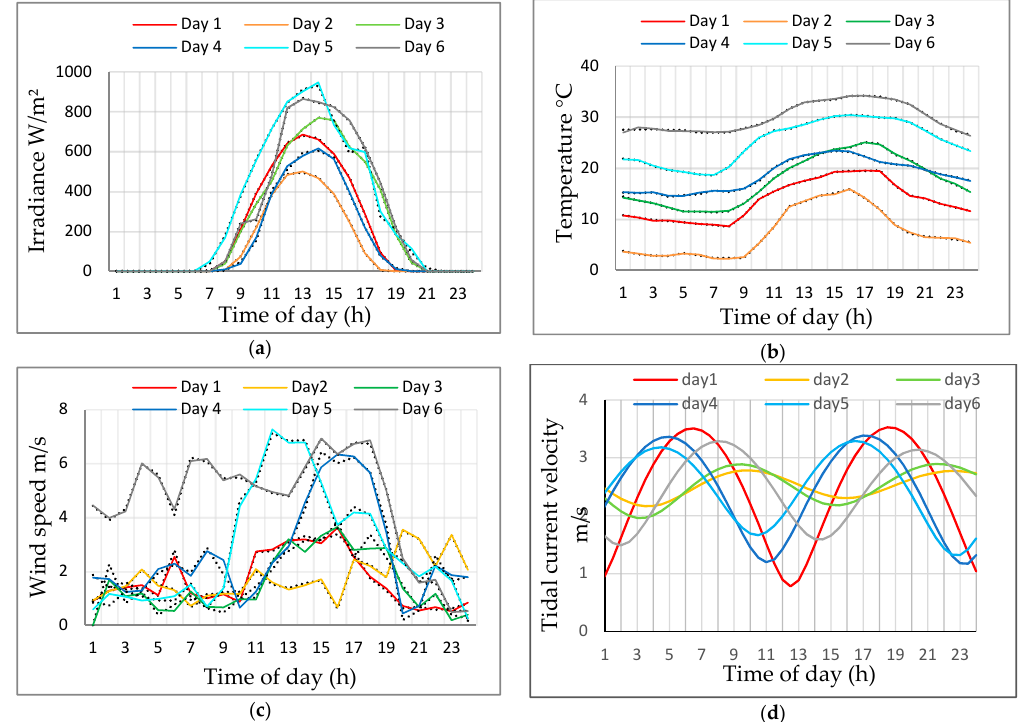
Figure 4. Data used as input to renewable energy systems (RES) models ( a ) Solar irradiance, in W/m 2 ; ( b ) Temperature, in °C; ( c ) Wind velocity, in m/s; and, ( d ) Tidal current velocity, in m/s.